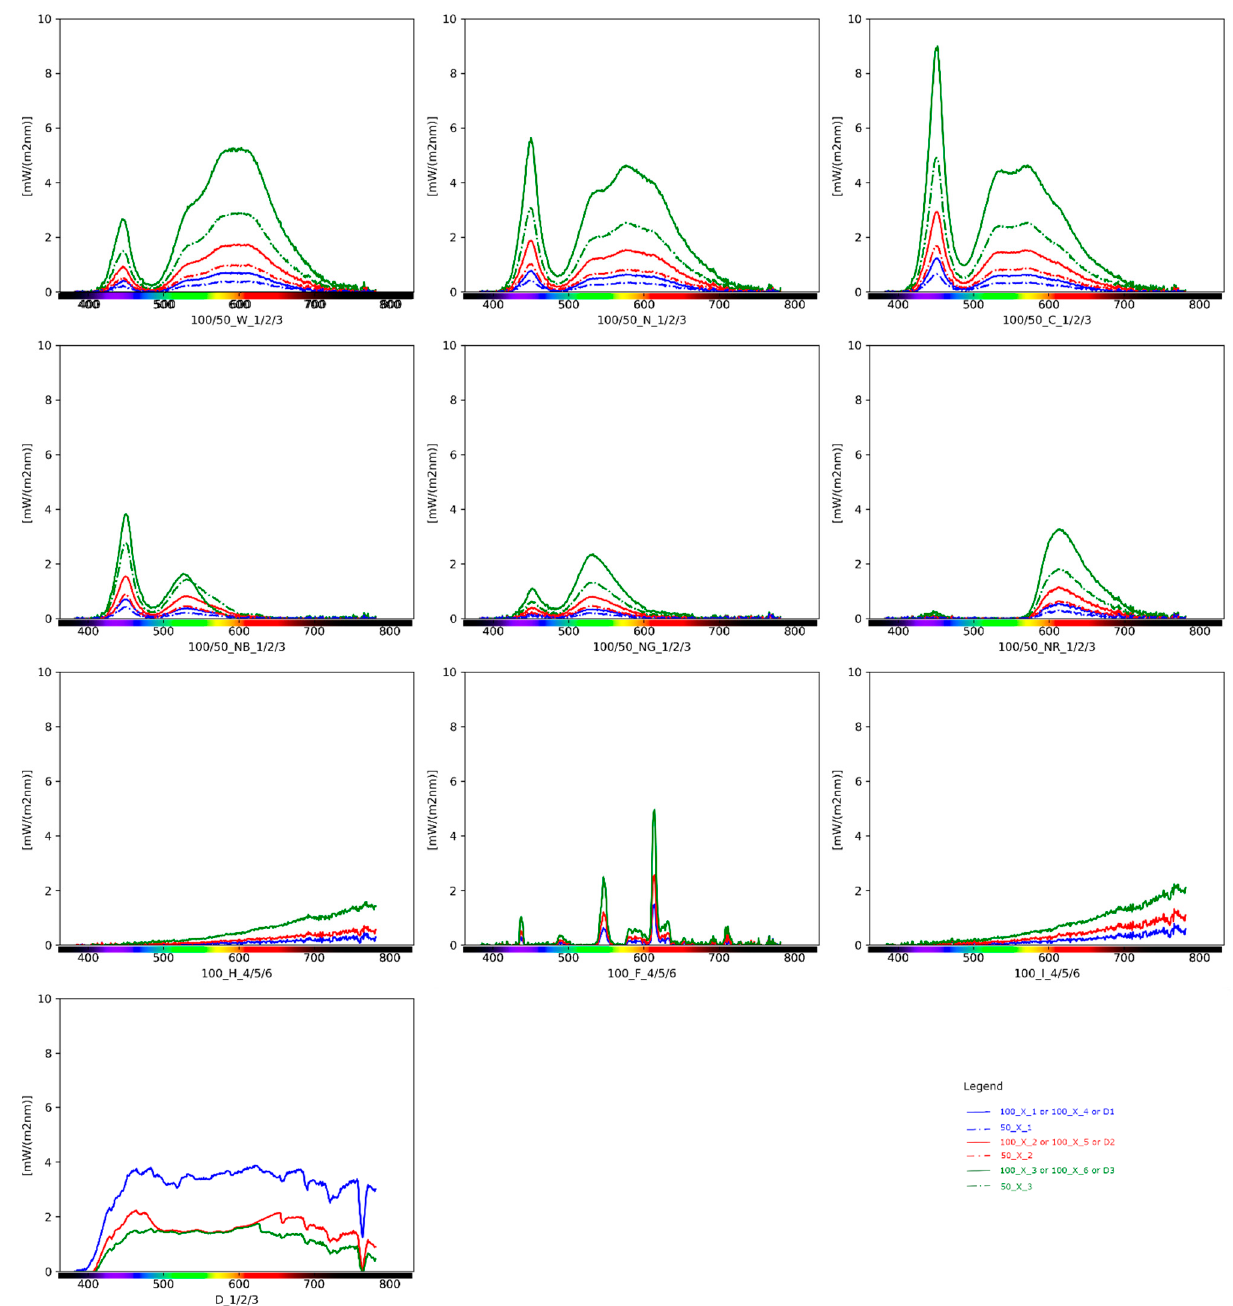
Figure 9. Spectrum plot differentiated for the different configurations: in the legend, X = W (Warm LED white) or N (Neutral LED white) or C (Cool LED white) or NB (Blue filter over Neutral LED white) or NG (Green filter over Neutral LED white) or NR (Red filter over Neutral LED white) or H (Halogen) or D (Daylight) or F (Fluorescent) or I (Incandescent); 100/50 = intensity; 1/2/3 or 4/5/6 = positions.